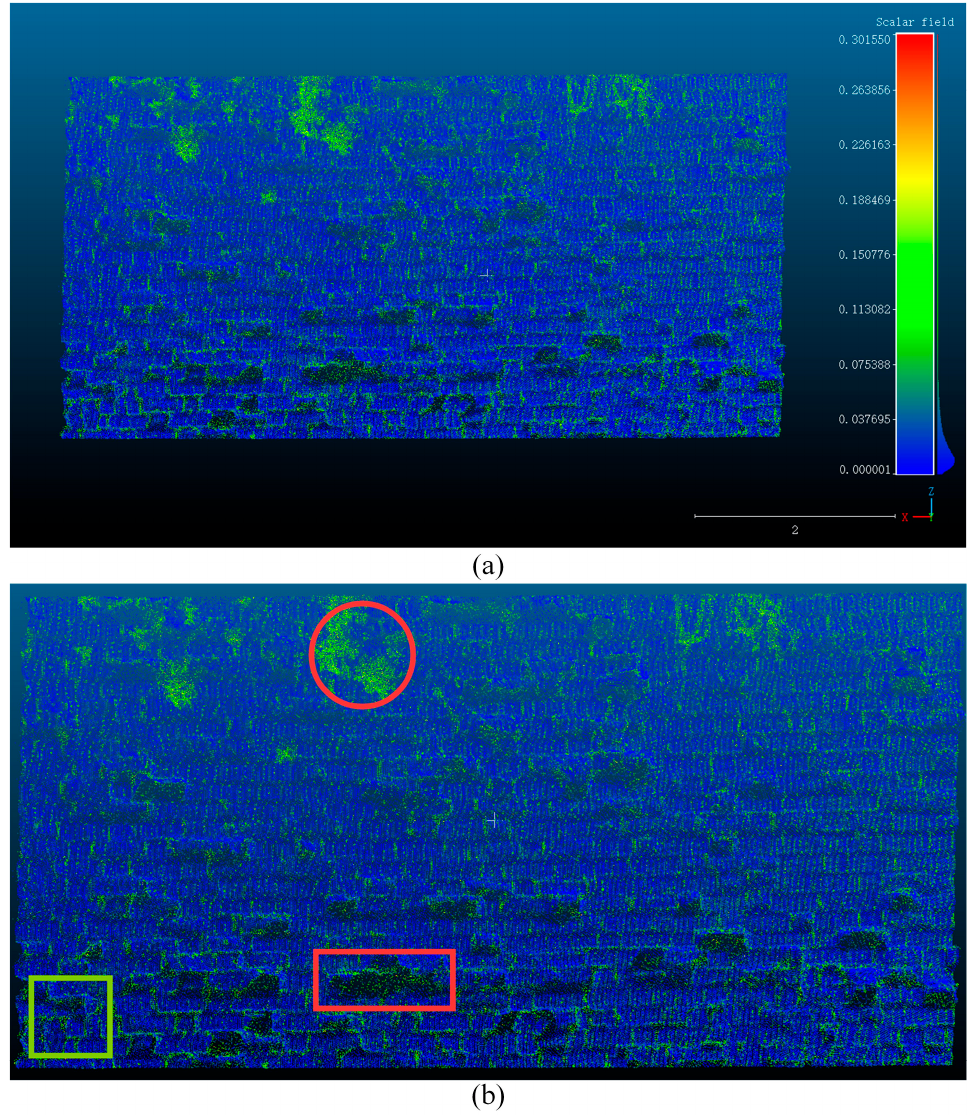
Figure 25. ( a ) Visualization of Curvature. ( b ) Defect analysis diagram. (The red box indicates the detachment of bricks; the green box indicates cracks in the wall, and the red circle is the area where the wall has been damaged by vegetation).